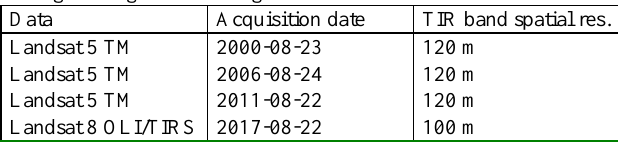
Table 1. The satellite data used in this research.